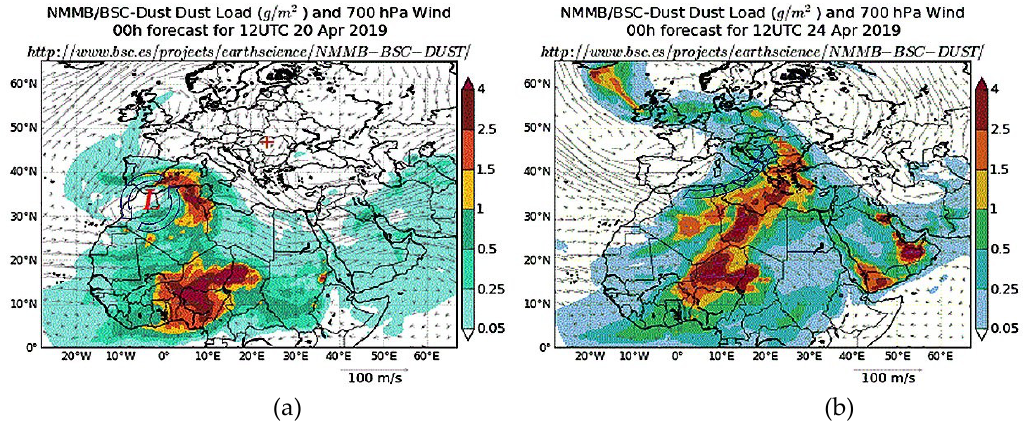
Figure 6. NMMB/BSC model dust load (pallete) and 700 hPa circulation (black arrows) for 20.04.2019, 12 UTC (a), and (b) for 24.04.2019, 12:00 UTC.